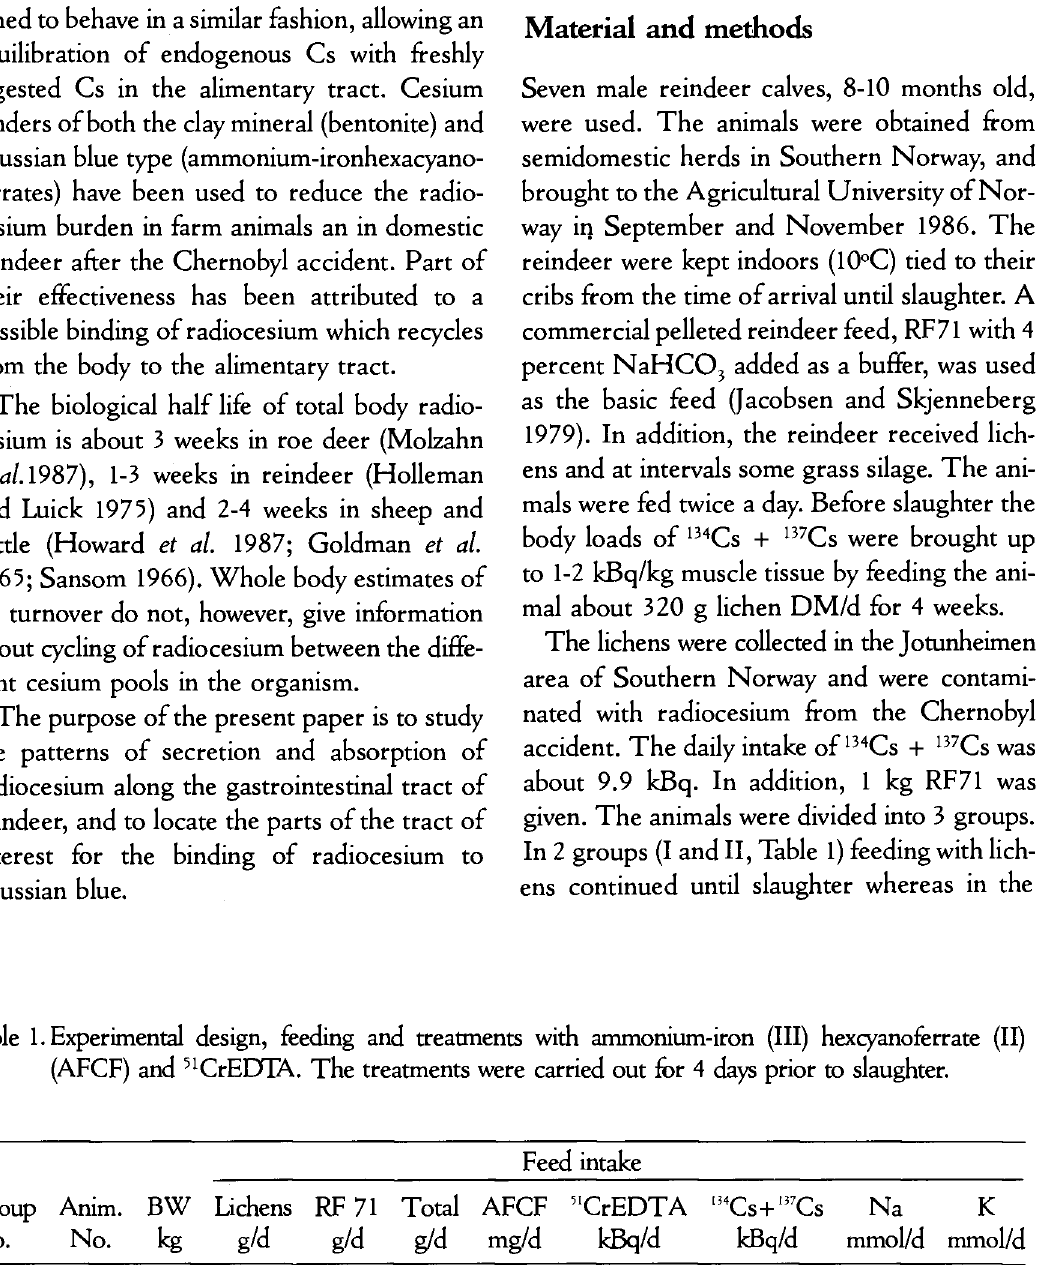
Table 1. Experimental design, feeding and treatments with ammonium-iron (III) hexcyanoferrate (II) (AFCF) and 51 CrEDTA. The treatments were carried out for 4 days prior to